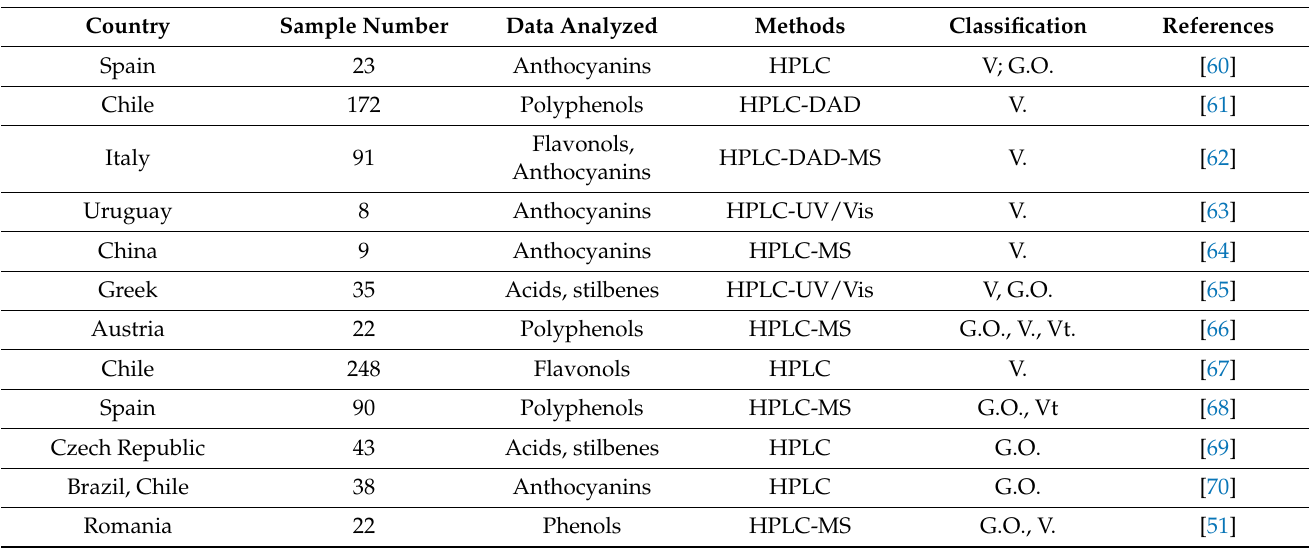
Table 2. Studies and analytical techniques to confirm the authenticity of wines characterized by the quantification of phenolic